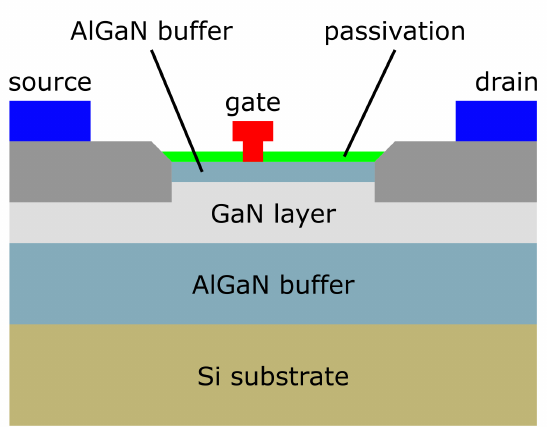
Figure 1. Simplified active layer profile of the D01GH and D006GH technologies.